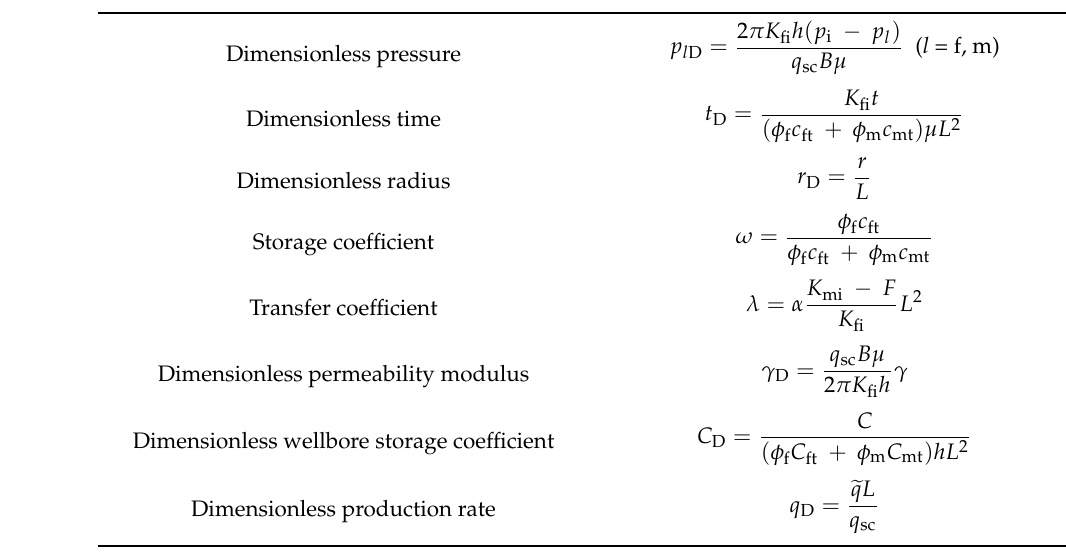
Table 1. Definitions of the dimensionless